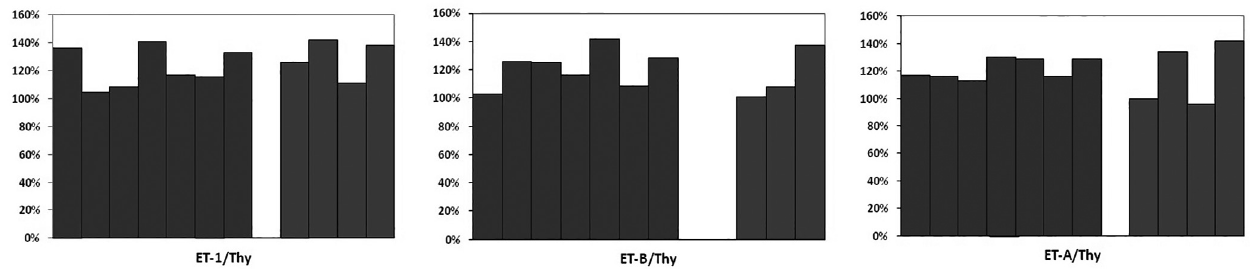
Fig. 3 - Results of quantitative analysis of ET-1 and ET receptors in mitral valves. Data presented as ET/Thy ratio (percent ET/ET receptor staining associated with fibrosis) in mitral valves from patients with RF undergoing valve replacement (n=7) and control tissue (n=4). RF=rheumatic fever;